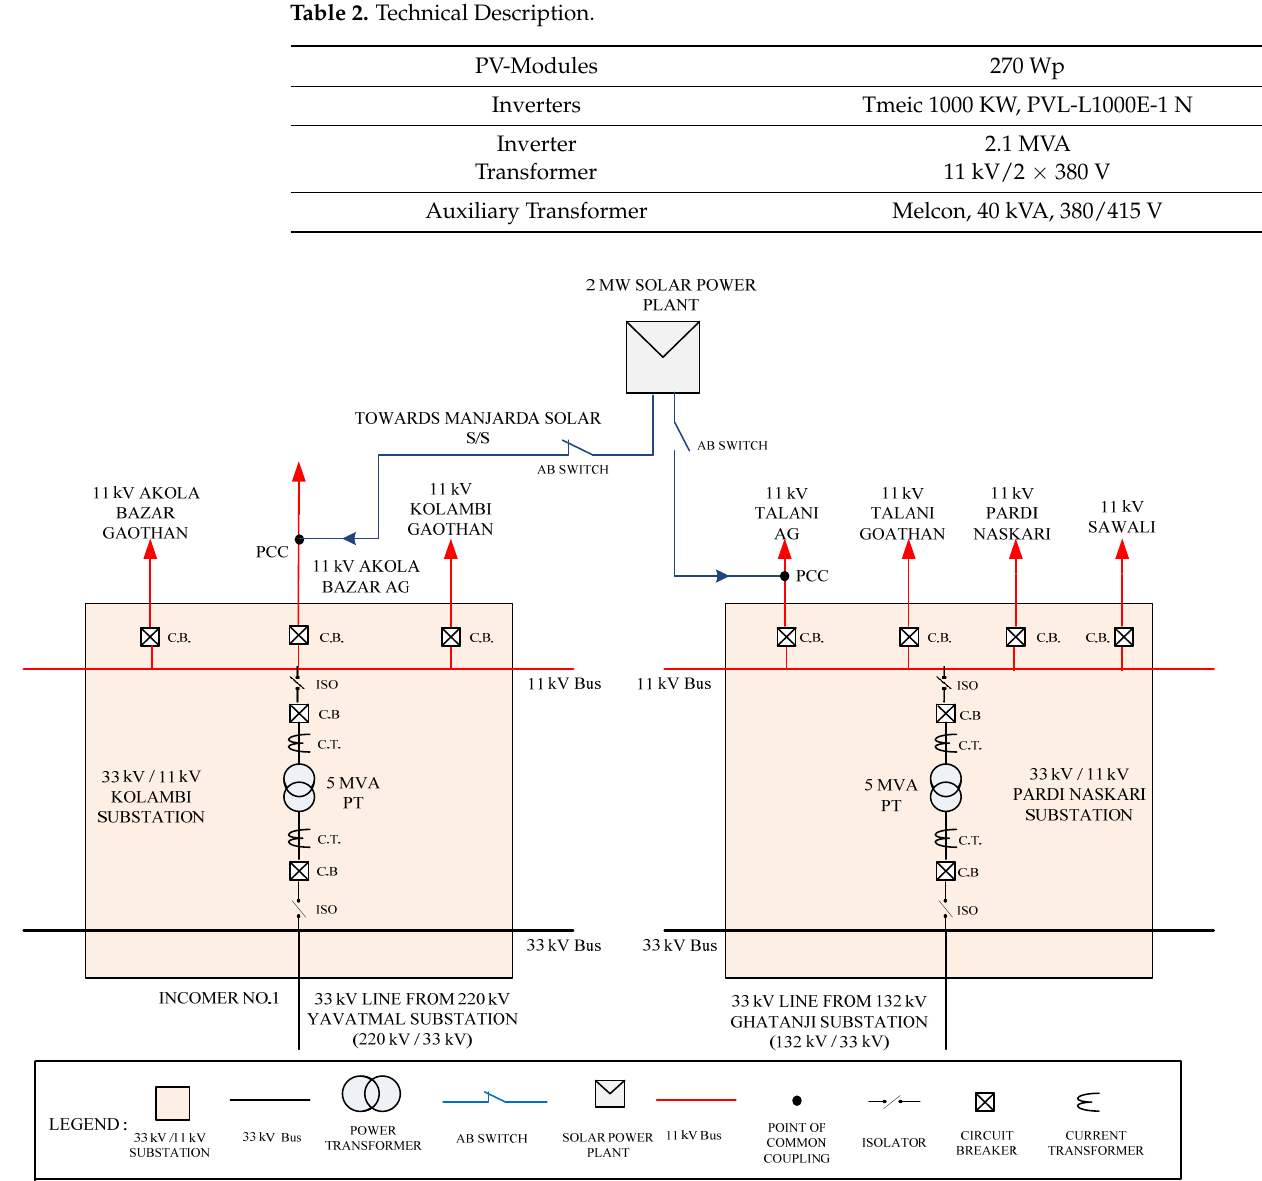
Figure 1. Single line diagram of 33 kV/11 kV Kolambi Substation and Solar Power Plant at village Manjarda.